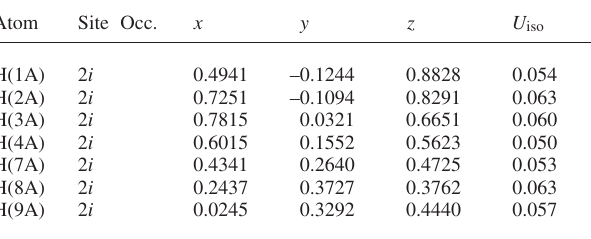
Table 2. Atomic coordinates and displacement parameters (in Å 2 )